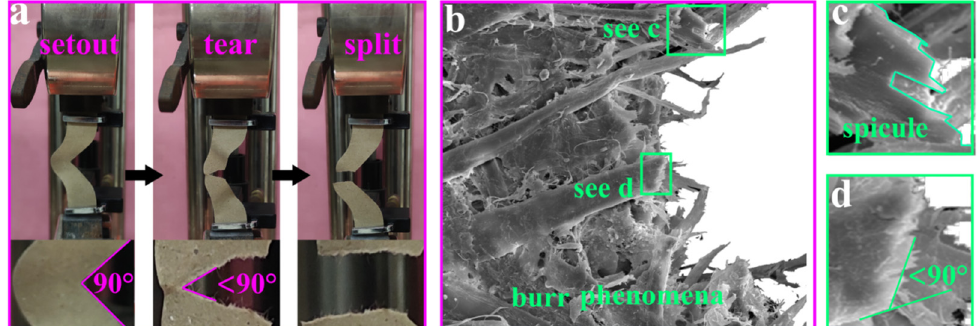
Figure 13. ( a ) Tearing process diagram, ( b ) Tearing fracture electron microscope diagram, ( c ) Tearing fracture fiber c enlarged diagram, ( d ) Tearing fracture fiber d enlarged diagram.